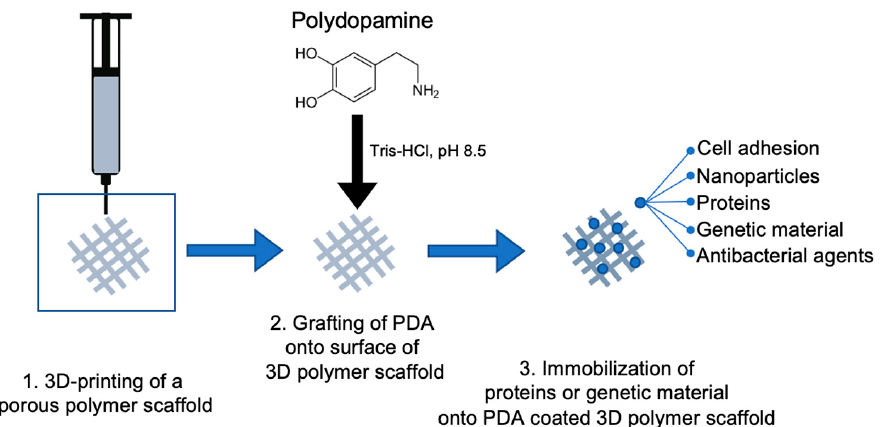
Figure 3. Schematic illustration of a general method in functionalizing a 3D-printed polymer scaffold by grafting polydopamine onto the surface allowing for the immobilization of various key cells, nanoparticles, proteins, genetic materials, or antibacterial agents to adhere firmly prior to and post- implantation to improve the desired therapeutic effect.